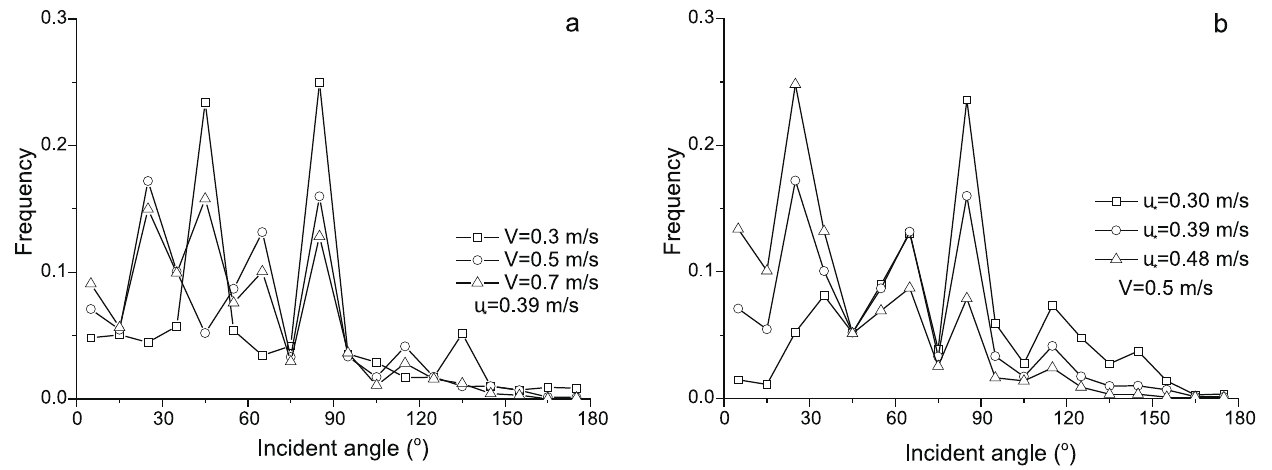
Figure 6. The distributions of incident angles of different particle speeds for a fixed wind strength (a) and of different wind strengths for a fixed particle speed (b).